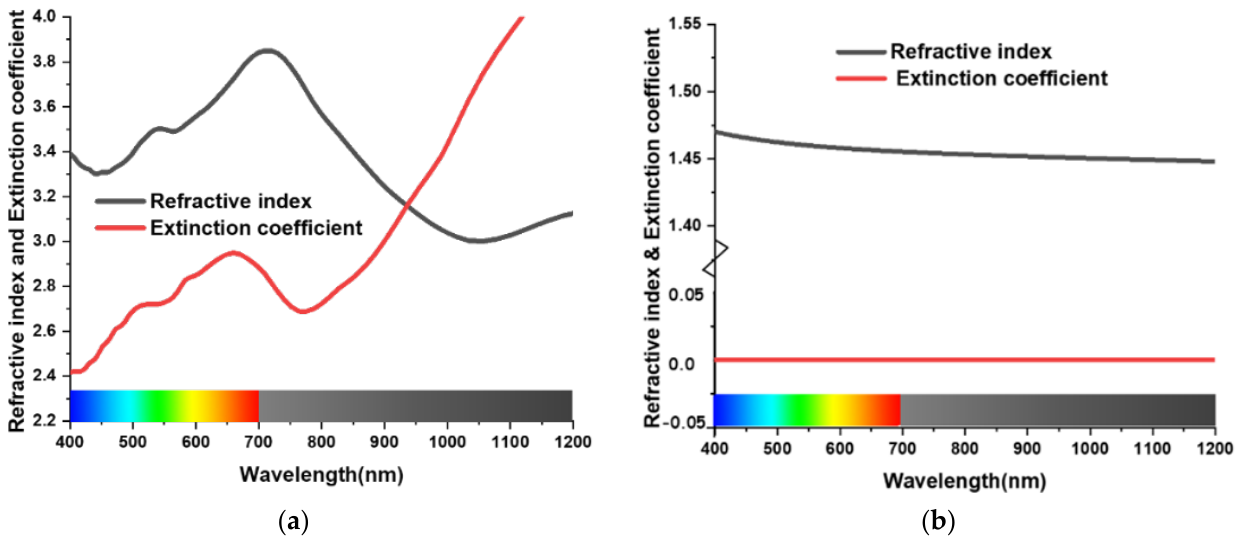
Figure 2. The refractive index and excitation coefficient of ( a ) tungsten and ( b ) SiO 2 in the optical and infrared range. Table 1. Structural parameters of the MA unit cell. Symble